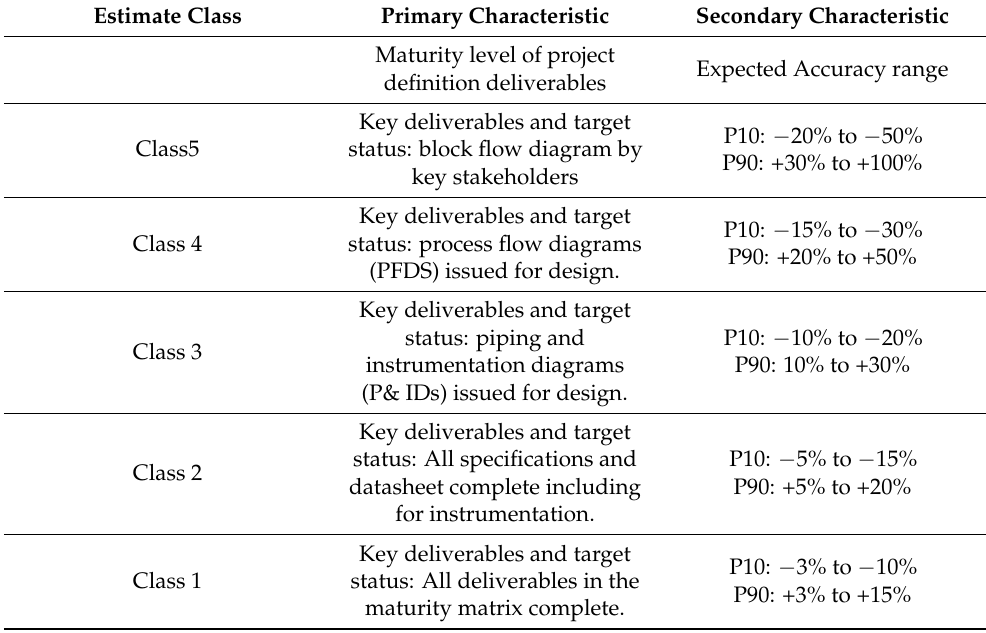
Table 5. AACE estimate Classes, the Maturity level of project definition deliverables and the Expected accuracy range [51].